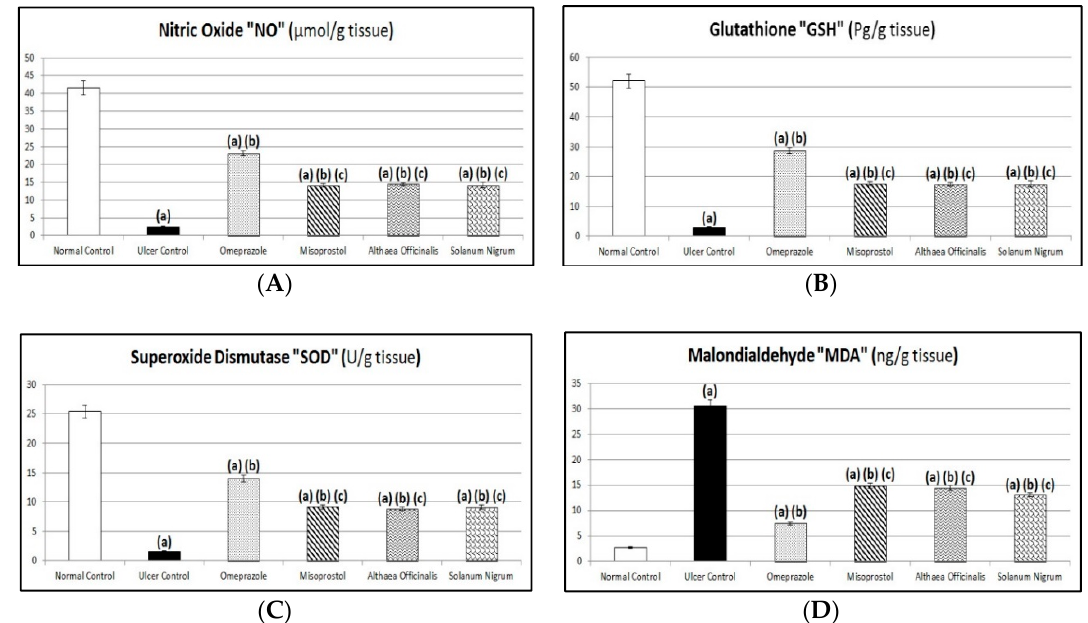
Figure 8. Protective effects of Althaea officinalis and Solanum nigrum with standards misoprostol and omeprazole on nitric oxide “NO” ( A ), glutathione “GSH” ( B ), superoxide-dismutase “SOD” ( C ), and malondialdehyde “MDA” ( D ) against pyloric-ligation/indomethacin-induced gastric-ulceration experimentally in male rats. Each value signifies the mean of 6–8 animals ± standard error of the mean. Statistical analysis was performed via one-way ANOVA test, and after that the Tukey–Kramer multiple comparisons test was done. Where: (a) indicates a significant difference from the normal control group ( p < 0.05), (b) indicates a significant difference from the gastric ulcer control group ( p < 0.05), and (c) indicates a significant difference from the omeprazole (1st standard pretreatment) group ( p < 0.05).